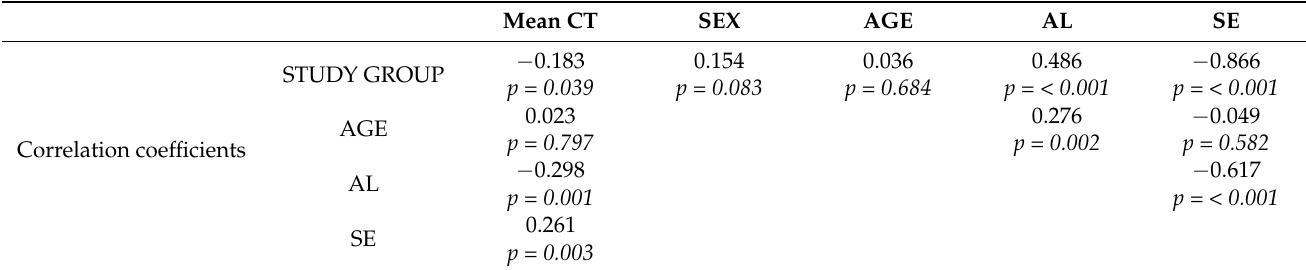
Table 2. Correlations between biometric factors and mean CT in all patients.